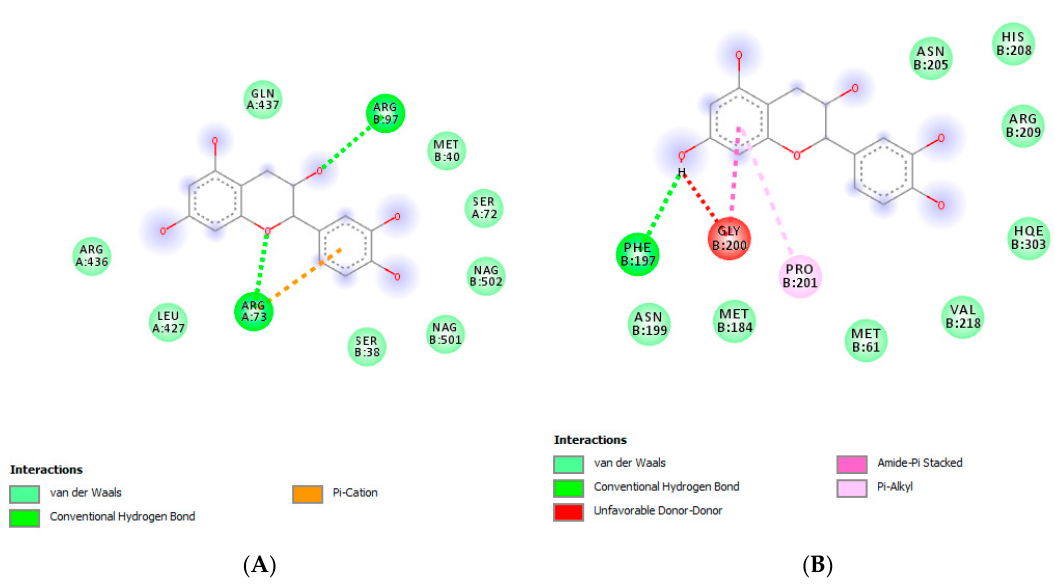
Figure 2. Putative interaction between catechin and human tyrosinase-related protein 1 (PDB: 5M8P). The free energy of binding ( Δ G) and affinity (Ki) are − 6.7 kcal/mol and 12.4 µM, respectively ( A ). Putative interaction between catechin and tyrosinase from Bacillus megaterium (PDB: 5I3B). The free energy of binding ( Δ G) and affinity (Ki) are − 6.6 kcal/mol and 14.7 µM, respectively ( B ).